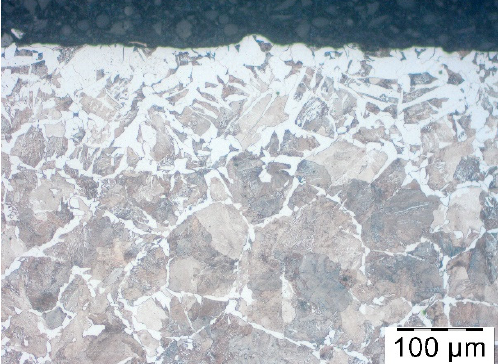
( b ) Figure 11. Microstructure in the surface layer of the forged part after hot forging and cooling—pre-coating of Bonderite in the concentration ( a ) 66% and ( b ) 50%. The last lubricant was Condursal in the concentration of 100%. Microstructure, as shown in Figure 12, indicates that the ferrite density is high but in the distance of approx- imately 50 μ m and gradually becomes a typical ferrite structure as seen in the deeper parts of the sample. It means that decarburization is prominent but does not go deep and is significantly weaker than in the case of a part with no coating at all.